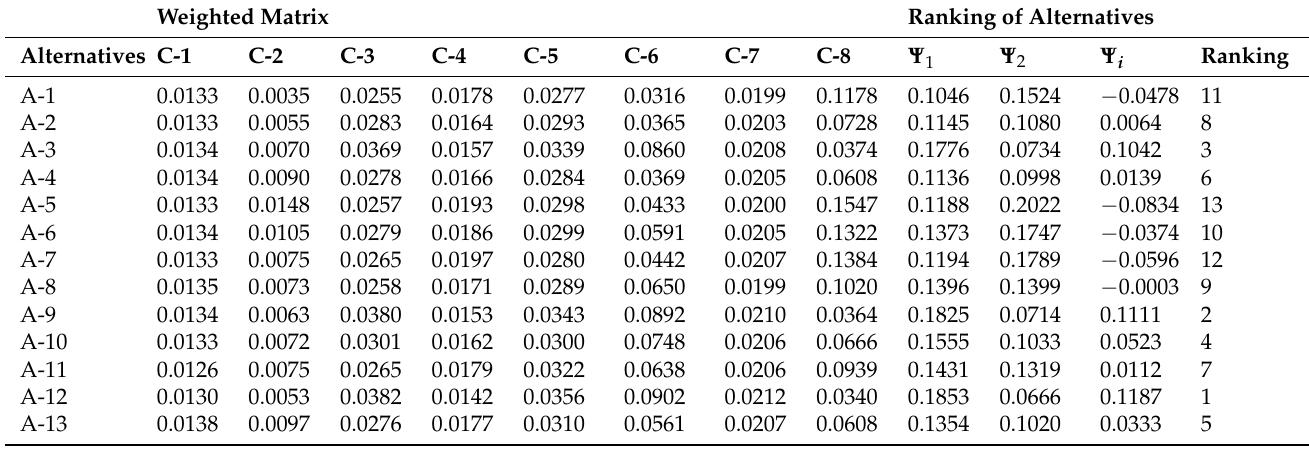
Table 6. Weighted matrix and ranking of alternatives.